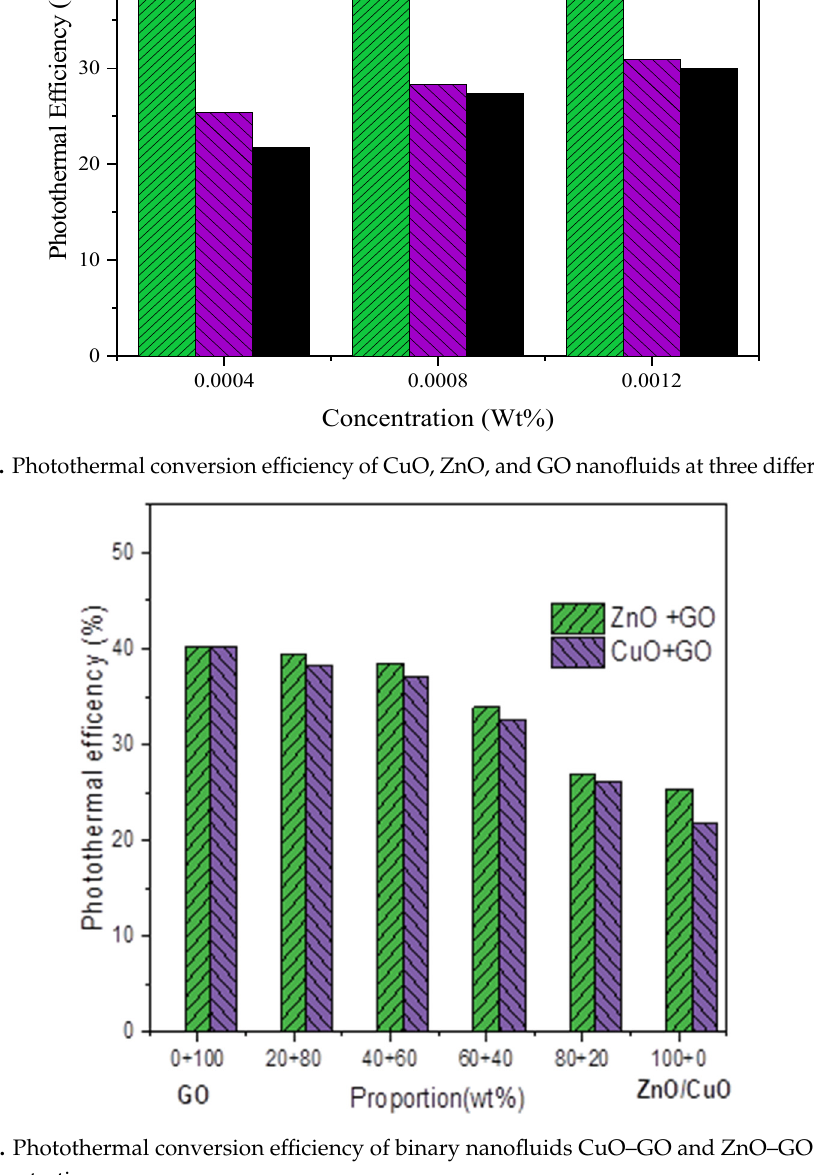
Figure 12. Photothermal conversion efficiency of binary nanofluids CuO–GO and ZnO–GO at 0.0004 wt % concentrations.